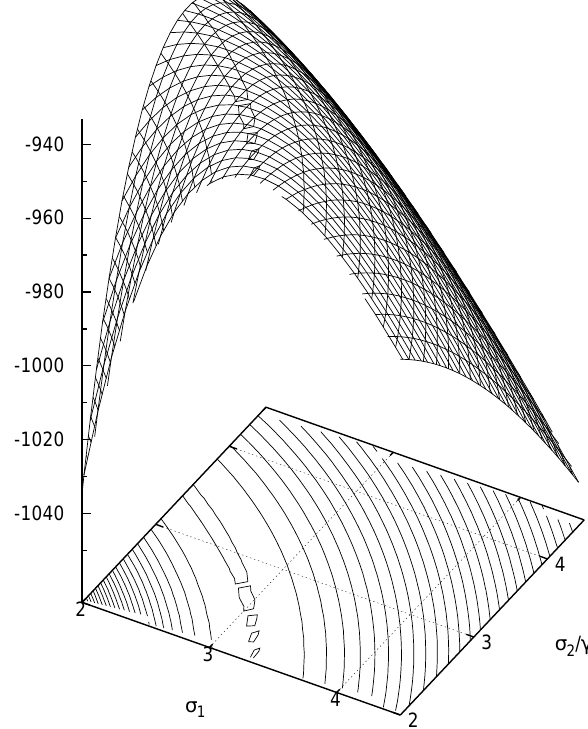
Fig. 5. Ice-core data: Log-likelihood as a function of the noise levels σ 1 and σ 2 . Neighbouring contours differ by a factor of 100 in likelihood. Fig. 6. Ice-core data: Log-likelihood as a function of σ 2 /γ for the oscillator model (solid) and as a function of τ for the one- dimensional potential model (dashed).